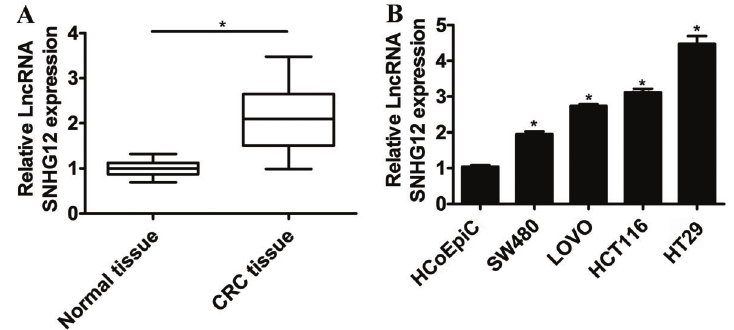
Figure 1. Relative expression of small nucleolar RNA host gene 12 ( SNHG12 ) in colorectal can- cer (CRC) tissues or normal tissues ( A ) and in dif- ferent CRC cell lines or the control cells HCoEpiC ( B ) detected by qRT-PCR. Data are reported as means ± SD. *P o 0.01 vs control (Student ’ s t